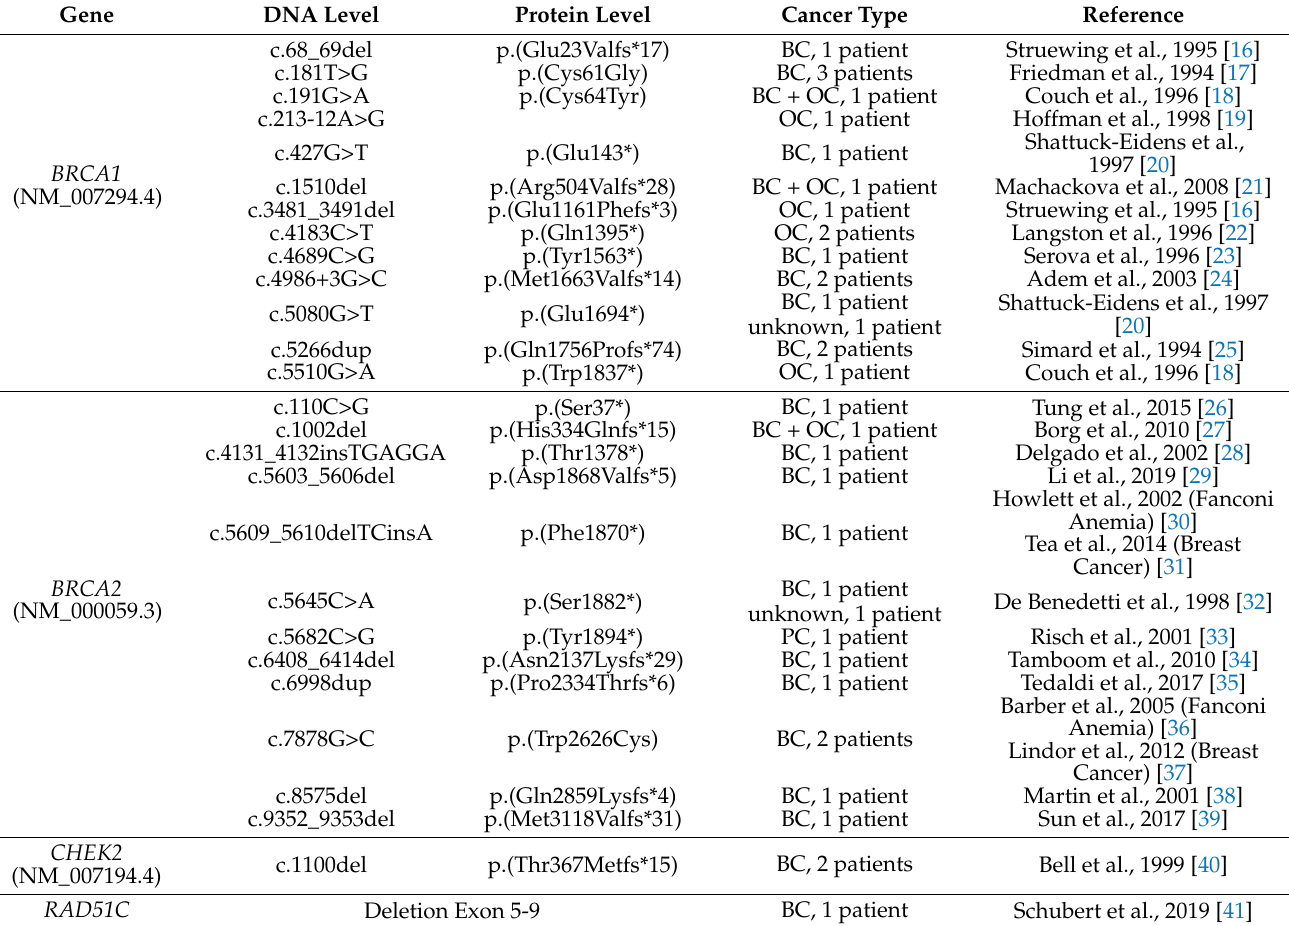
Table 2. Pathogenic variants in the BRCA1 , BRCA2 , CHEK2 , and RAD51C genes